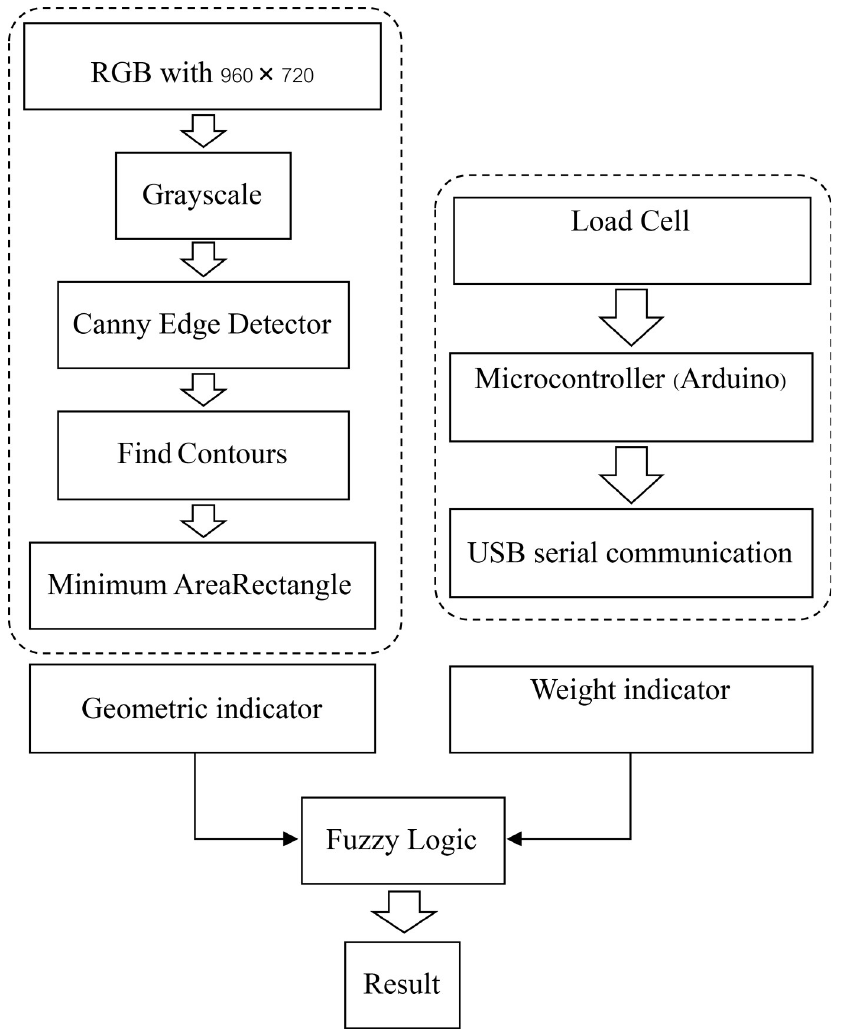
Fig 15. Procedure to develop a program for a double yolk eggs